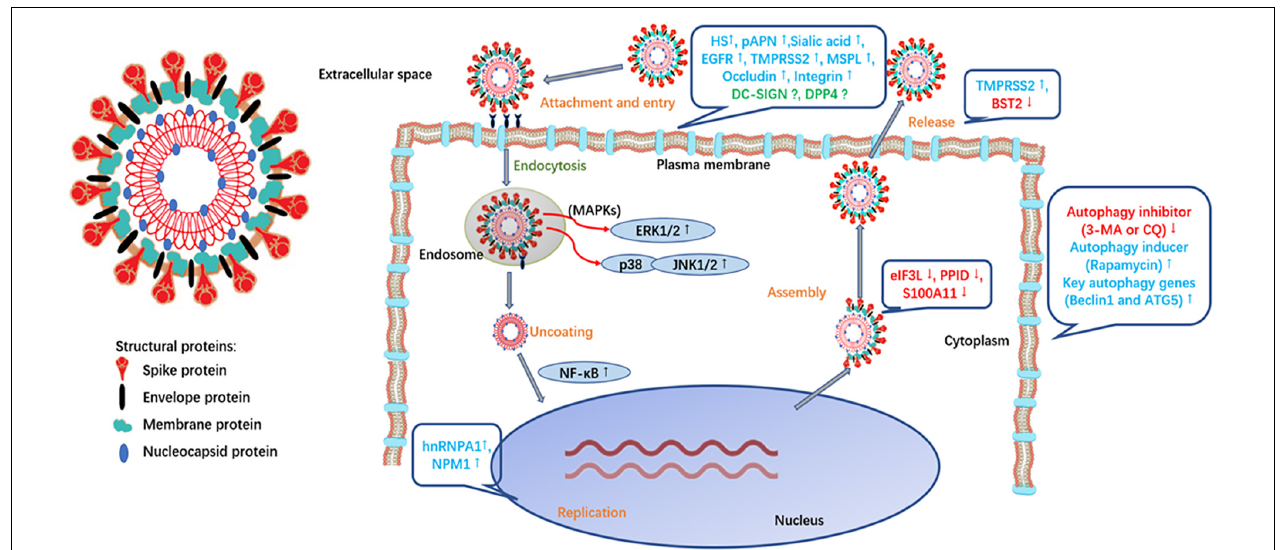
FIGURE 2 | The involvement of numerous host factors and viral proteins in the different processes of PEDV infection. During the process of virus attachment and entry into cells, the host factors pAPN, HS, sialic acid, EGFR, TMPRSS2, MSPL, occludin, and integrin are found to promote PEDV infection by interacting with the S protein. DC-SIGN and DPP4 may play a role in this process as well, while more robust evidence is needed. HnRNPA1 and NPM1 are verified to interact with the N protein of PEDV, thus participating in the transcription and replication stages. Finally, TMPRSS2, BST2, eIF3L, PPID, and S100A11 are identified to take part in the assembly and release of the virus. PEDV also utilizes the p38 MAPK and JNK signaling pathways for optimal replication. Similarly, PEDV infection induces endoplasmic reticulum (ER) stress response and activation of the NF- κ B signal also contributes to PEDV replication. Additionally, PEDV can facilitate its replication by affecting autophagy. ↑ , ↓ in the figure denote promotion or inhibition,